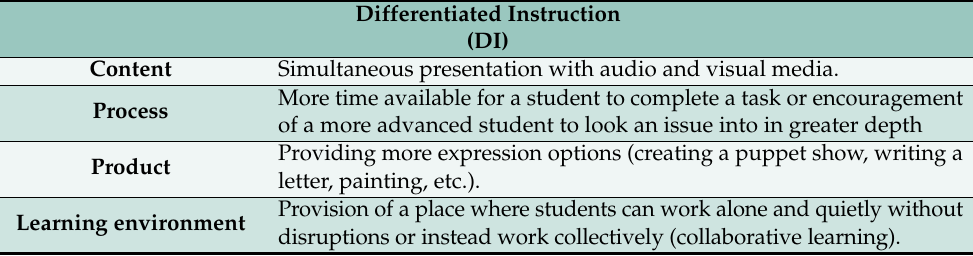
Table 1. Examples of differentiated